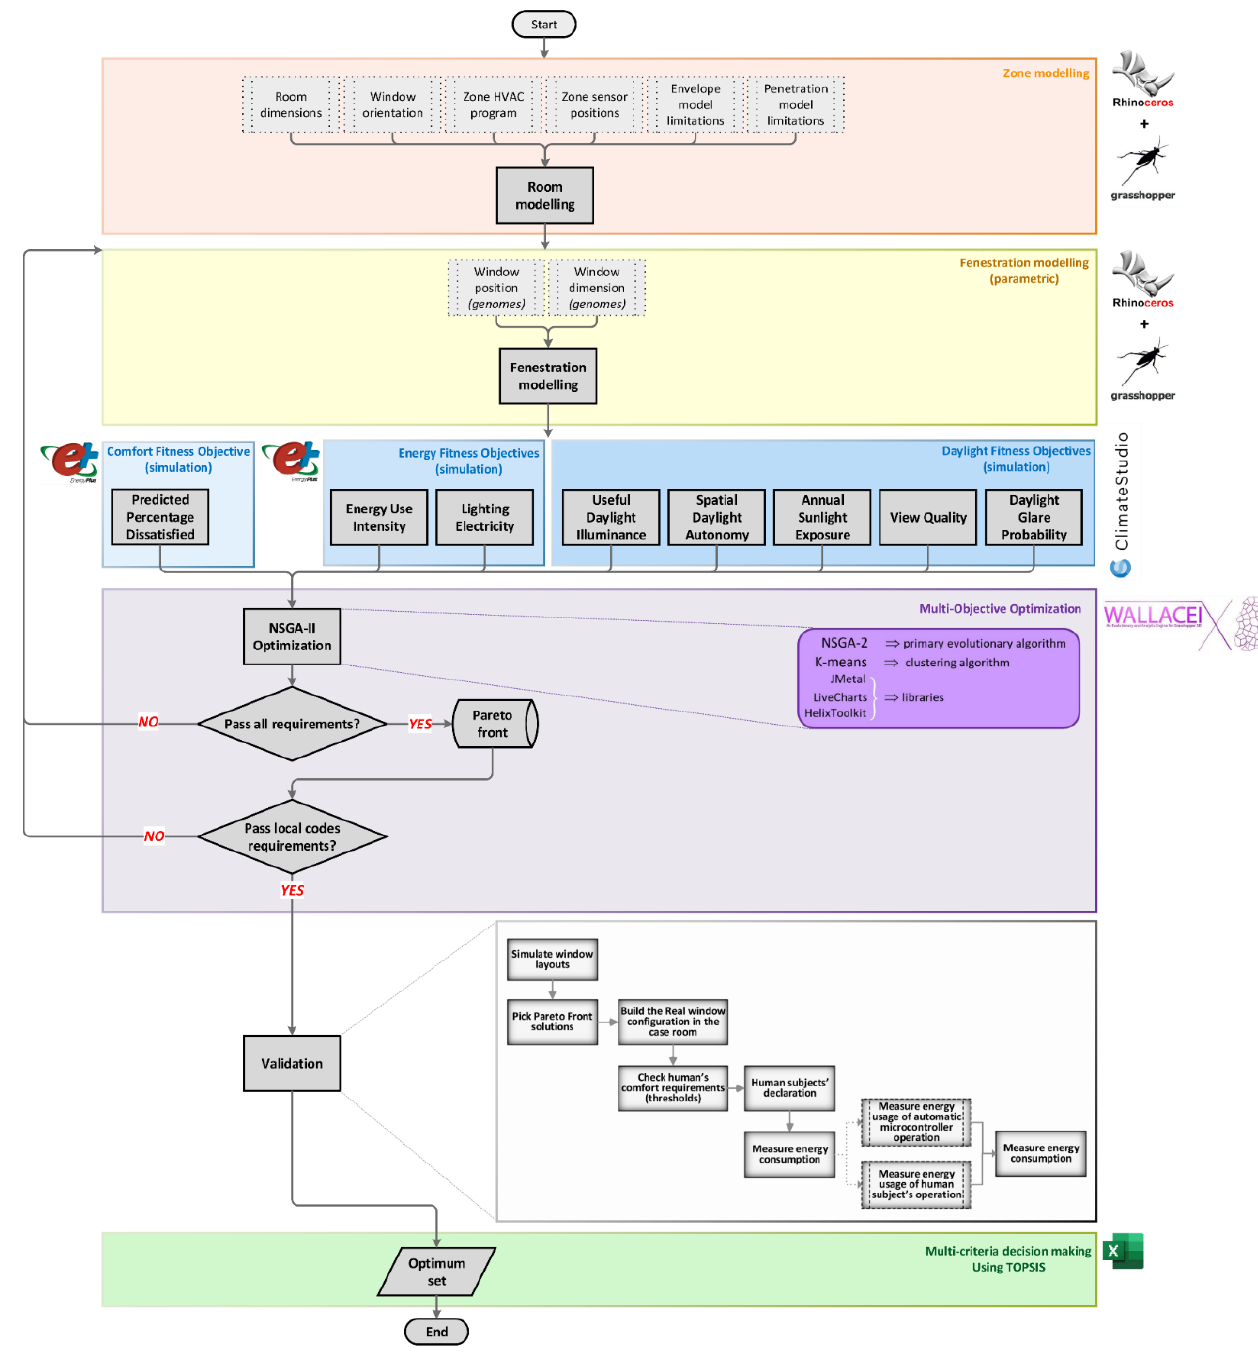
Figure 3. The research flowchart shows every step and technique/engine/software used.